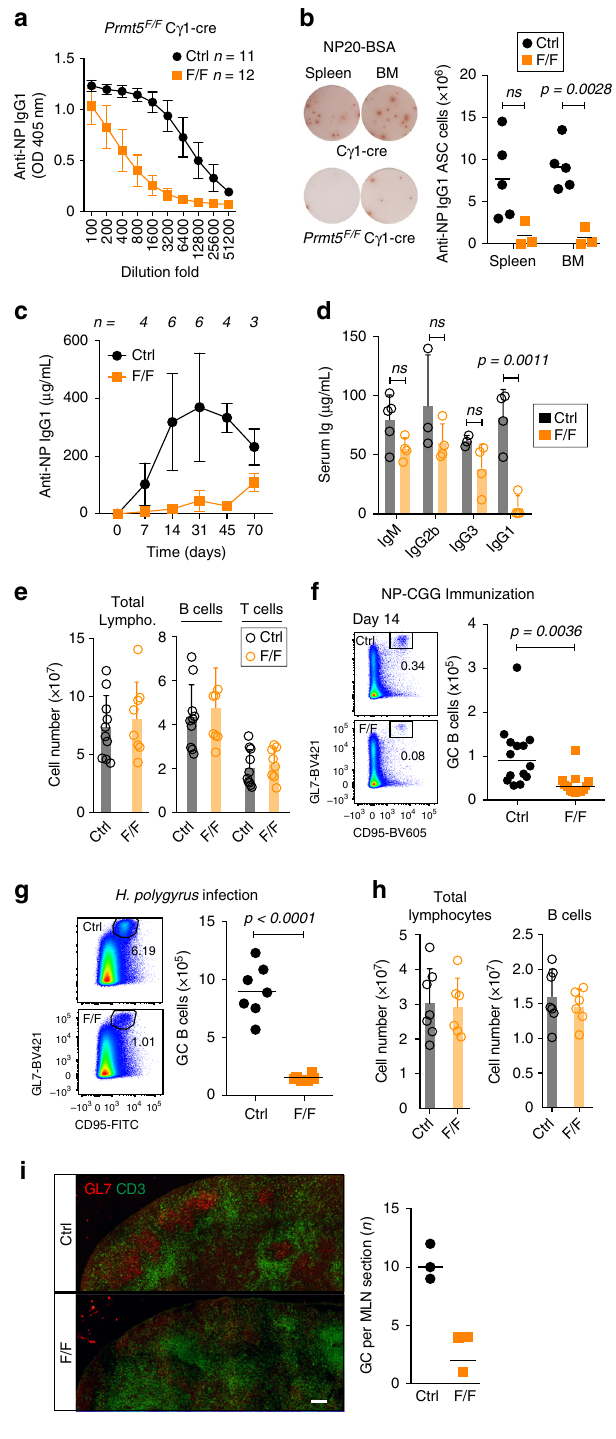
Fig. 4 Antibody response and GC defects caused by Prmt5 de fi ciency. a – i C γ 1-cre (Ctrl) and Prmt5 F/F C γ 1-cre (F/F) mice were used throughout. a Total anti-NP IgG1 in the serum of mice, measured by ELISA 14 days after NP-CGG immunization. Mean ± s.d. OD values for serial dilutions are plotted for n mice from three experiments. b Representative pictures of ELISPOT for NP-speci fi c IgG1 antibody secreting cells (ASC) at day 14 post- immunization. The number of ASC of individual mice (symbols) and means (bars) are plotted. c Anti-NP IgG1 in the serum of mice at various times post-immunization. Mean ± s.d. values for n mice at each time point from two experiments are plotted. d Total levels of antibody isotypes in the serum of n non-immunized mice. e Mean + s.d. number of lymphocytes per spleen at day 14 post-immunization, enumerated by fl ow cytometry for n mice from two experiments. f Representative fl ow cytometry plots (gated on B220 + ) of splenic GC B cell proportions at 14 days post-immunization with NP-CGG. The number of GC B cells per spleen for individual mice (symbol) and medians (bars) from three experiments are plotted. g As in f , for MLN of mice infected with H. polygyrus for 14 days. Data from two experiments are plotted. h Mean + s.d. number of lymphocytes per MLN in the mice from g . i Representative IF in MLN from mice infected with H. polygyrus from g , stained for the indicated antigens. Scale bar, 100 µ m. GC numbers per MLN scored in individual mice (symbols) are plotted to the right. p -Values throughout are by an unpaired, two-tailed Student's t test